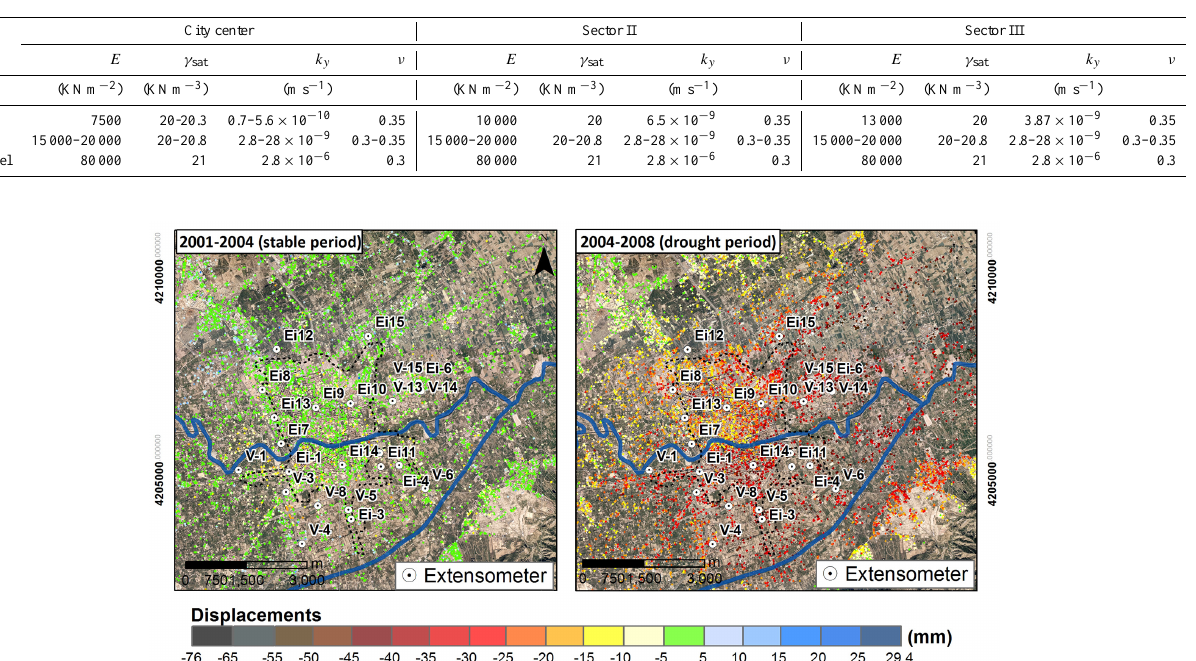
Table 1. Summary of the geotechnical properties of the soils from the metropolitan area of Murcia city (from Mulas et al., 2010 and Tessitore et al., 2015). γ sat : specific saturated weight [KNm − 3 ]; k y : vertical permeability [ms − 1 ]; E : Young’s modulus [KNm − 2 ]; ν : Poisson’s coefficient.